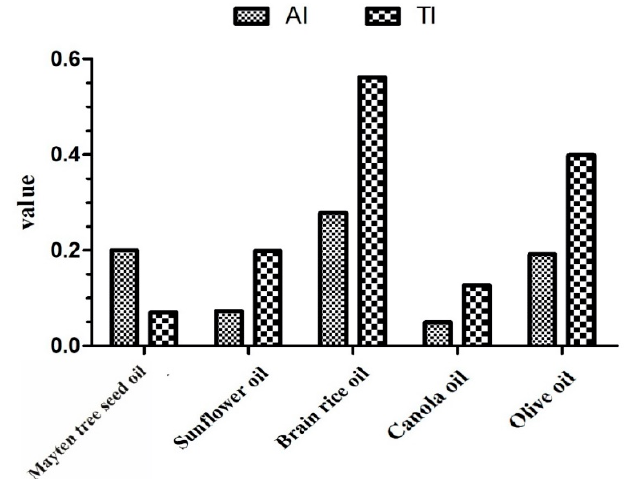
Figure 2. Atherogenic index (AI) and thrombogenic index (TI) values among Mayten tree seed oil and other commonly consumed seed oils (adapted from ref. [50]).